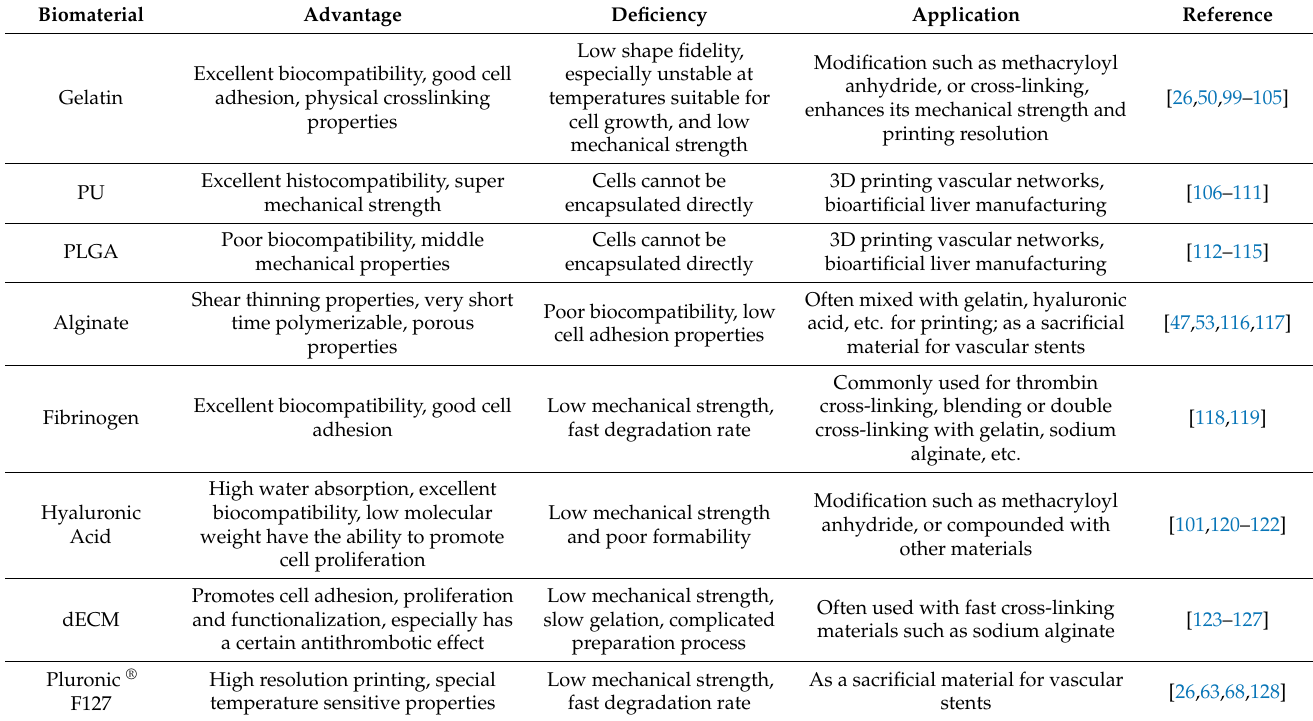
Table 1. The commonly used polymers in vascular model